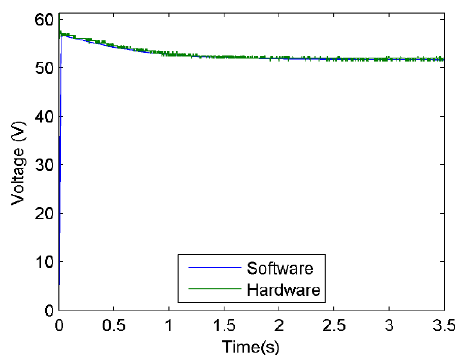
Figure 31. PVPE current response with PI CSE.